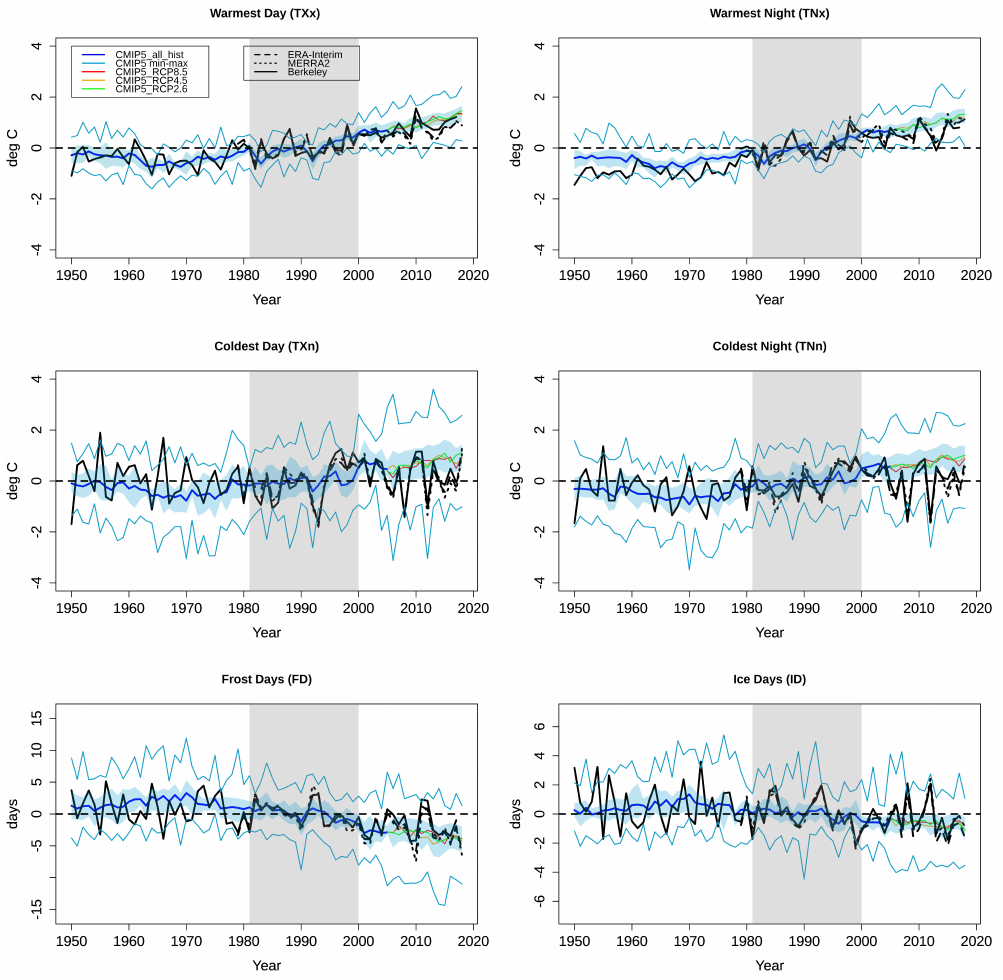
Figure 9. Annual anomalies (from the reference period 1981–2000—shaded area) of the MENA domain (land only) average of absolute and threshold temperature indices of extremes derived from: (i) CMIP5 ensemble mean (blue: historical, green: RCP 2.6, yellow: RCP 4.5, red: RCP 8.5). The blue shading indicates the inter-quartile model range and the light blue lines represent the maximum and minimum values. (ii) Observational data (black lines, dashed: ERA-Interim, fine dashed: MERRA-2, solid: Berkeley